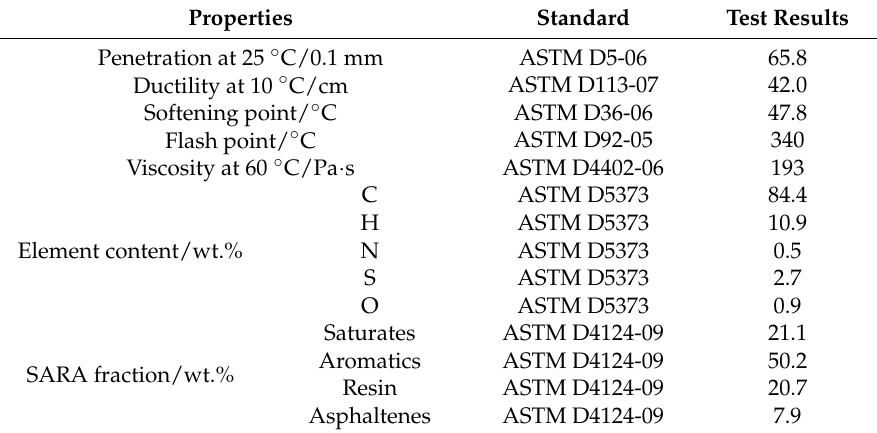
Table 1. Basic properties of the base asphalt